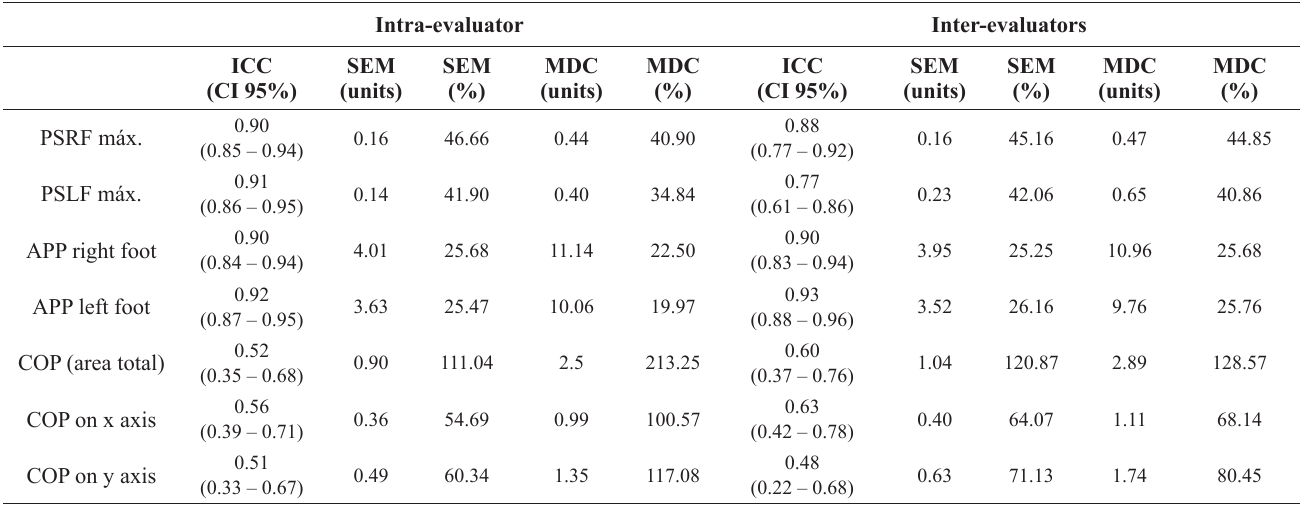
Table 4 - Intra and inter-evaluators reliability results for plantar pressure and stabilometry in children up to 7 years old. Intra-evaluator Inter-evaluators